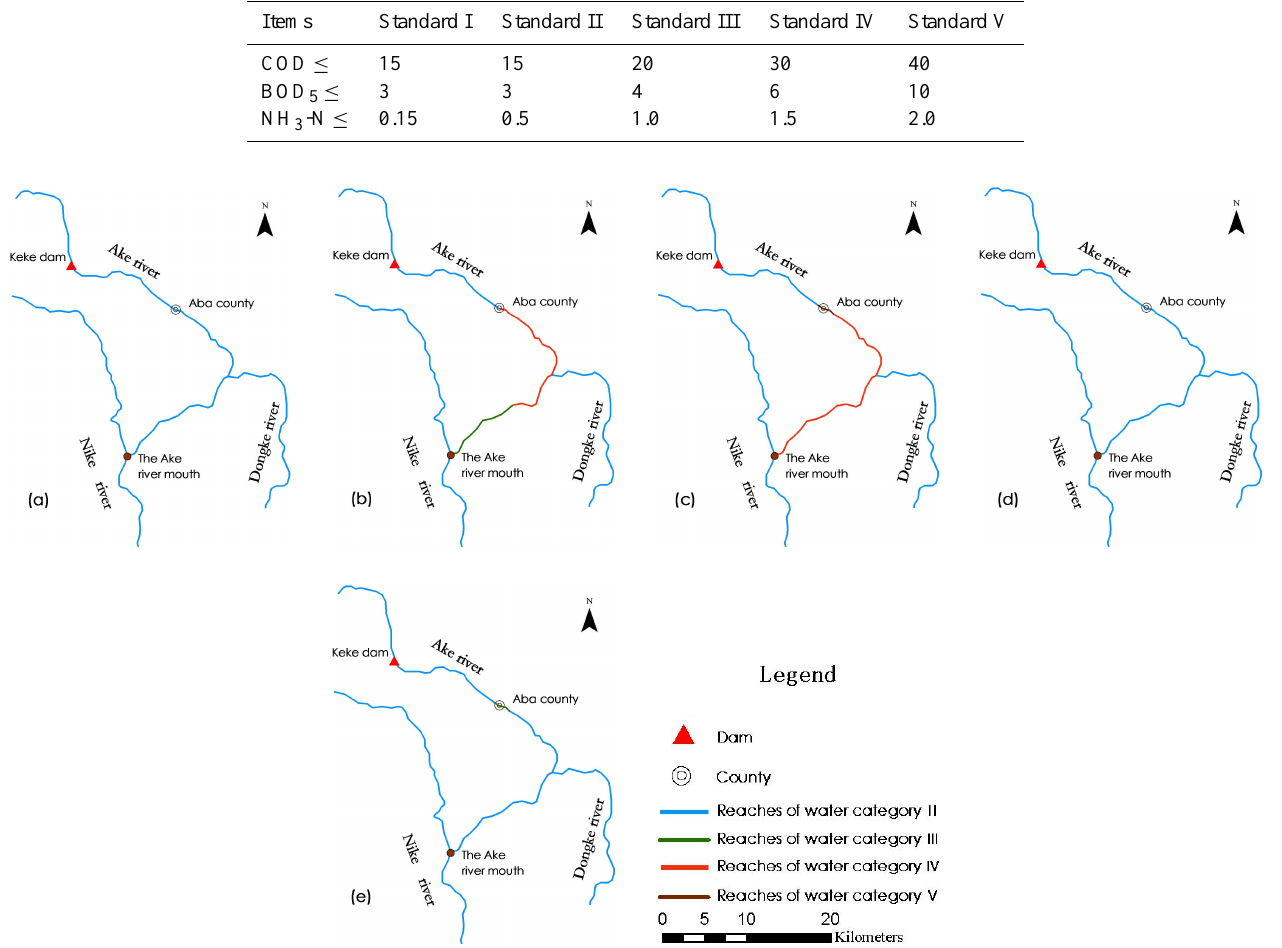
Fig. 8. The water quality of Ake River reaches below the dam sites in February under different scenarios. (a) , (b) , (c) The three target years of 2010, 2020 and 2030, respectively, without pollution control; (d) 2010 with pollution control, (e) 2020 and 2030 with pollution